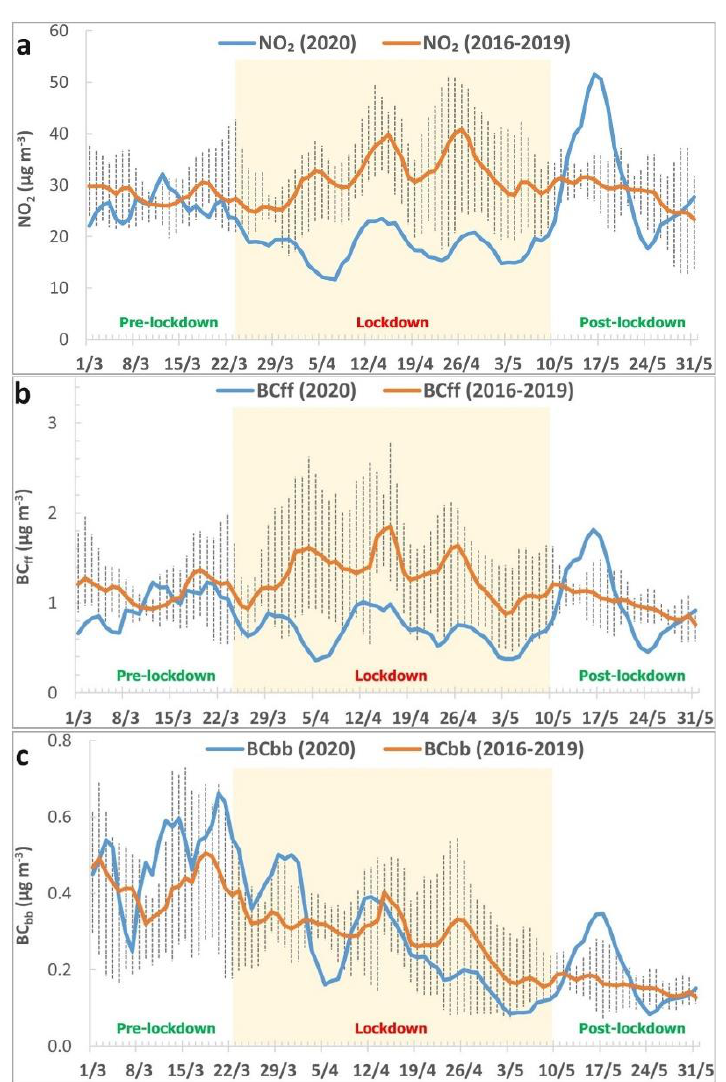
Figure 5. 7–day running mean for pollutant concentrations ( a ): NO 2 , ( b ): BC ff , ( c ): BC bb , measured in 2020 and 2016–2019, in Athens (Thissio). Displaying 4-year averages of running mean values and minimum−maximum range (dashed-lines) for 2016–2019.